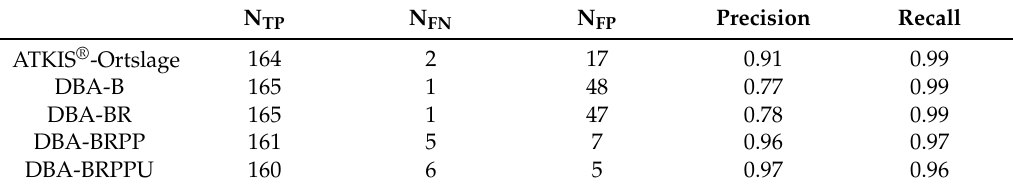
Table 5. Number of true positive (TP), false positives (FP) and false negative (FN) classified settlements. N TP N FN N FP